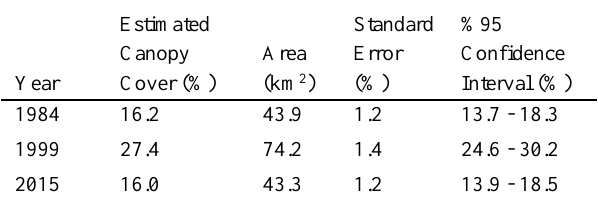
Table 1. Summary statistic of assessed urban tree canopy cover with the random point sampling approach within GPCA